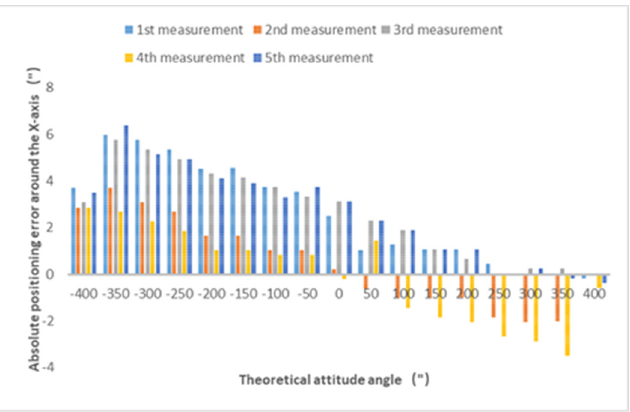
Figure 17. Absolute positioning error of the attitude deflected around the x-direction.